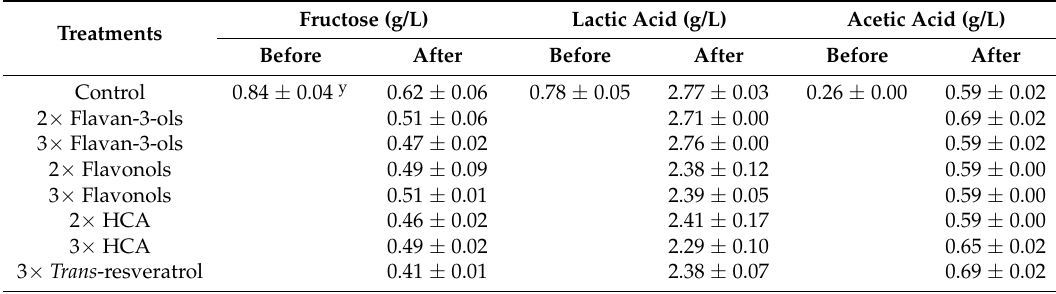
Table 2. Effect of phenolic compounds addition on the apparent sugar and organic acids metabolism of wine LAB after 28 days of MLF, initiated by O. oeni Oenos™ Citric Acid (g/L) Fructose (g/L) Lactic Acid (g/L) Acetic Acid (g/L) Treatments Before After h Before After Before After Before After